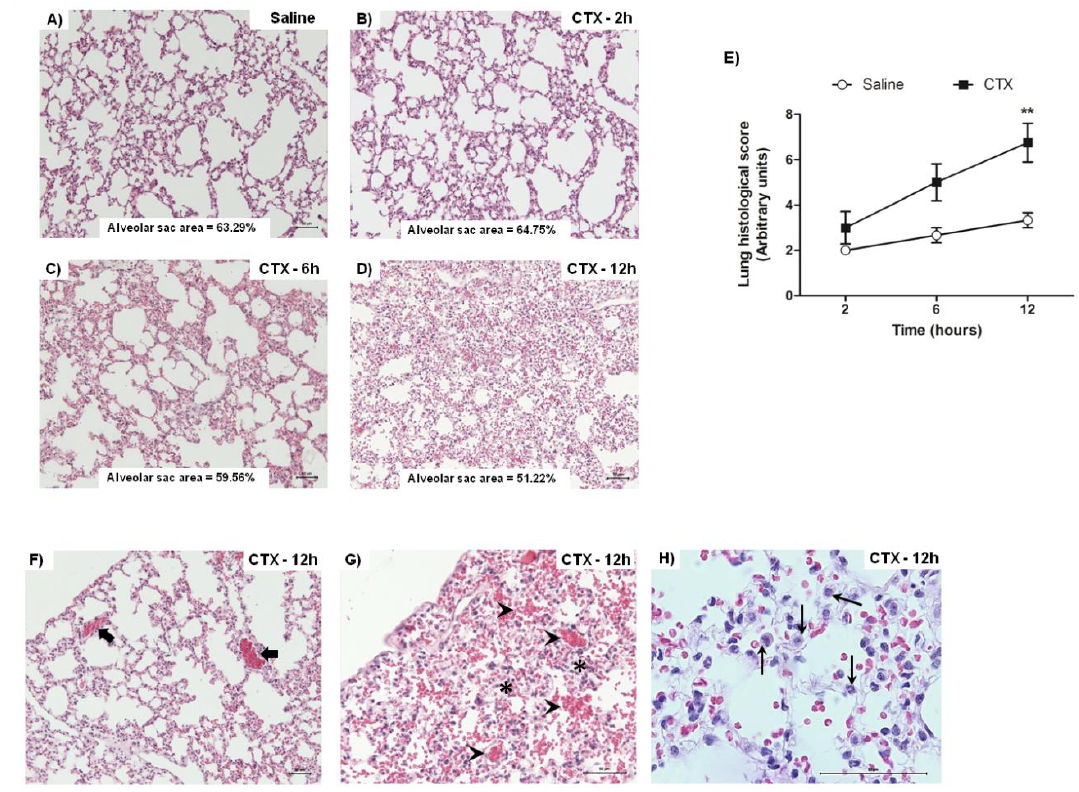
Figure 2. Histological alterations in mice lung induced by CTX. Representative sections of lungs from mice treated with saline or CTX (300 µ g / Kg s.c.) for 2, 6, or 12 h. ( A–D ) Images from HE-stained sections were captured at 20X magnification (scale is represented in the image) and alveolar sac area was calculated using the IM-50 software. ( E ) Lung injury score was graded from 0–3 for each animal, and the result is representative of the mean of injury score. ( F – H ) Lung alterations after 12 h of CTX treatment: vascular congestion (thick arrow), edema (asterisk), alveolar hemorrhage (arrow head), and leukocyte infiltrate (thin arrow). ** p < 0.01 vs. saline-treated mice (control)—two-way ANOVA followed by the Bonferroni’s post-test ( n = 3 animals/group).